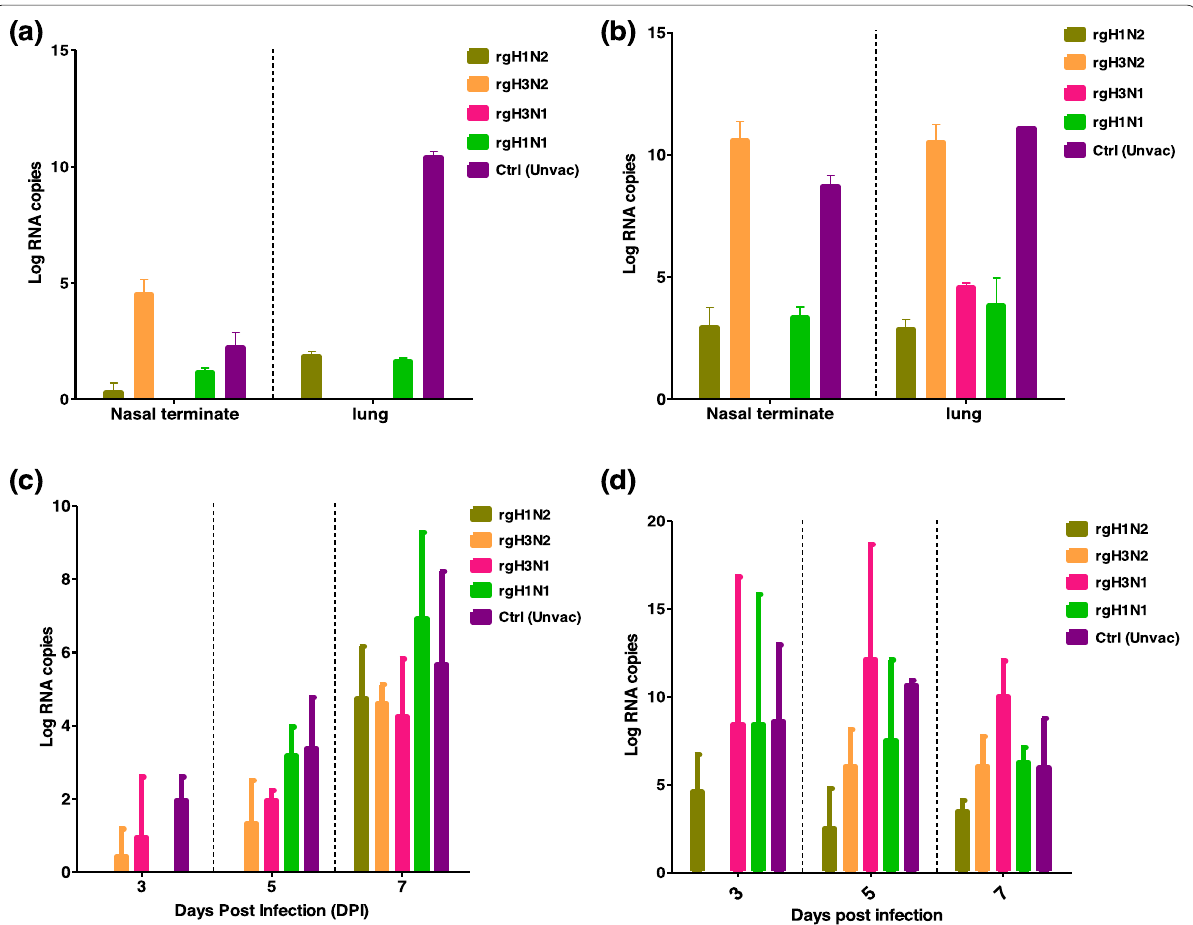
Fig. 8 Viral shedding or viral loads in lungs, nasal terminates, and nasal washes of the vaccinated and control mice ( n lungs and nasal terminates were detected in challenged mice with influenza A/H3N2 ( a ) and A/H1N1 ( b ) at day 3 post-infection. The viral loads in nasal washes were detected on days 3, 5, and 7 post-infection with H3N2 ( c ) or H1N1 ( d ) using semi-quantitative